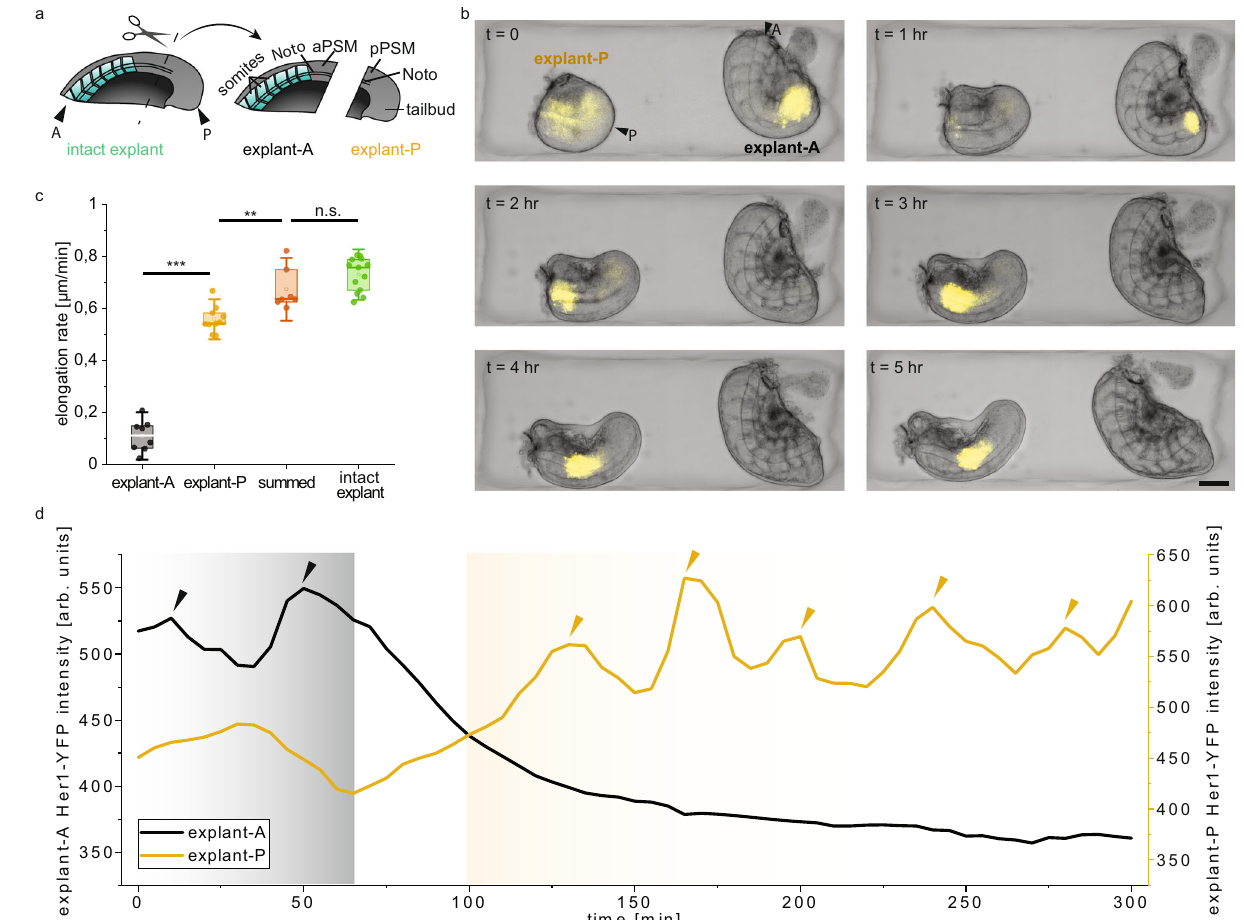
Fig. 3 | Dynamics of elongation and signalling in the anterior and posterior partsofthe tail explant are independent.a Schematicshowing the dissectionof the tailexplant into ananterior (explant-A)and a posterior (explant-P)piece. Right schematicshowsthemainstructureswefocusoninthispaperforexplant-Aand-P (A: anterior, P: posterior, Noto: notochord, a/pPSM: anterior/posterior PSM). b Composite image of BF and YFP channels showing the elongation and Her1-YFP expression in explant-A and explant-P cut from the same tail explant. A and P are placed on the top left image to indicate the anterior and posterior of the entire explant.Scalebar,100 µ m. c Elongationratesoftheexplant-A( N =4, n =8),explant-